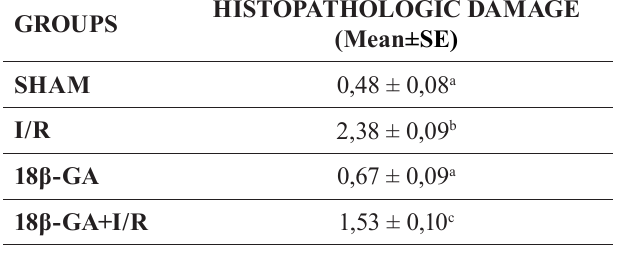
TABLE I - C omparison of the effect of 18 β -GA